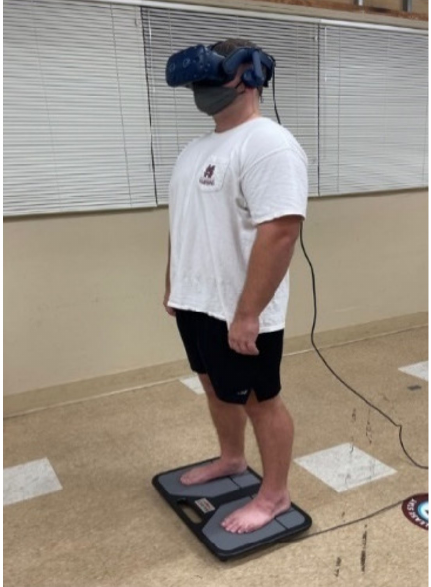
Figure 1. Participant performing the virtual reality (VR) claustrophobia trials using the HTC Vive Pro™ standing on a BTrackS™ balance force